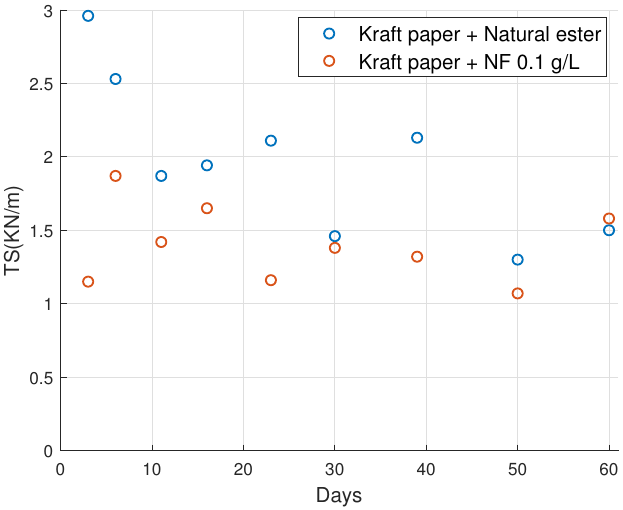
Figure 3. Tensile strength of paper vs. aging